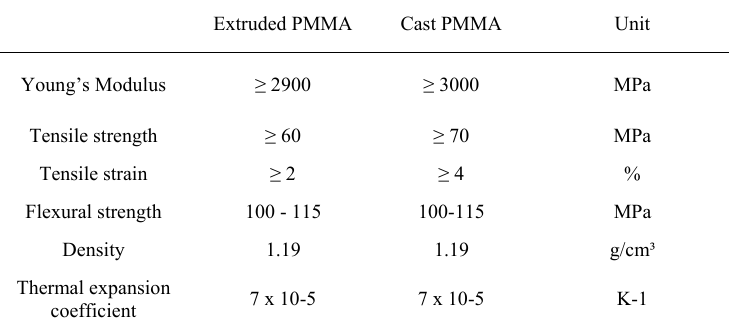
Table 1: Material Properties PMMA.